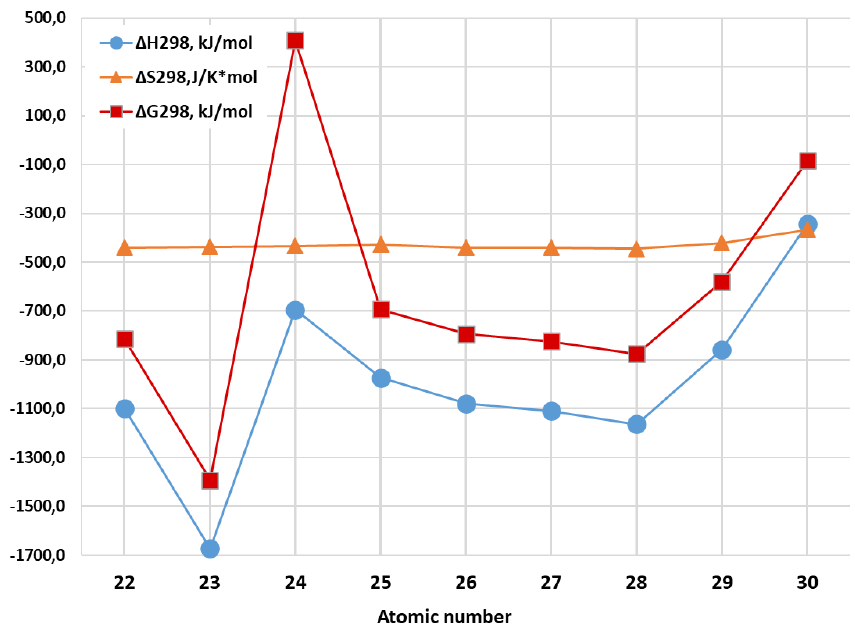
Figure 5. The dependences of the thermodynamic parameters of the reaction (1) of 3 d -element atomic number.